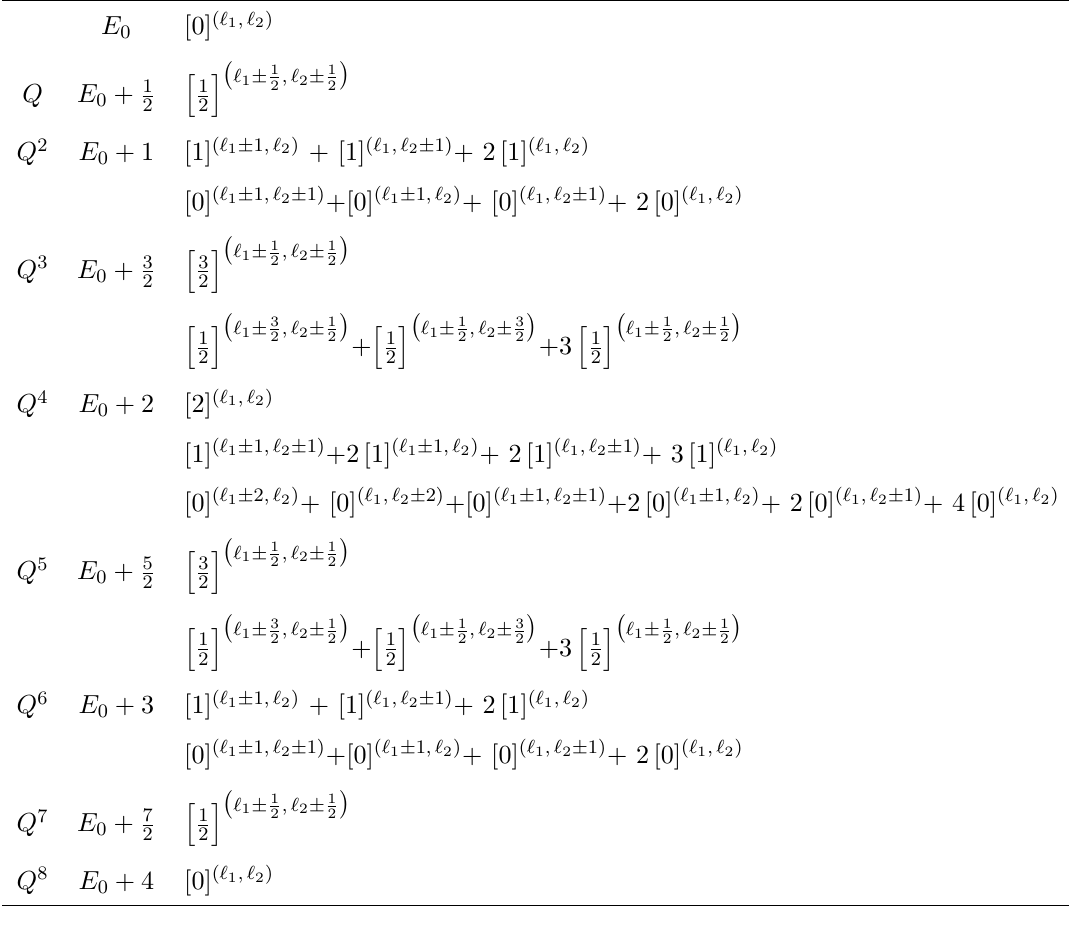
Table 12 . States in the long graviton supermultiplet LGRAV 4 [ E 0 , ‘ 1 , ‘ 2 ] , with ‘ 1 , ‘ 2 ≥ 3 ‘ i = 3 , negative Dynkin labels at the Q 4 level are 2